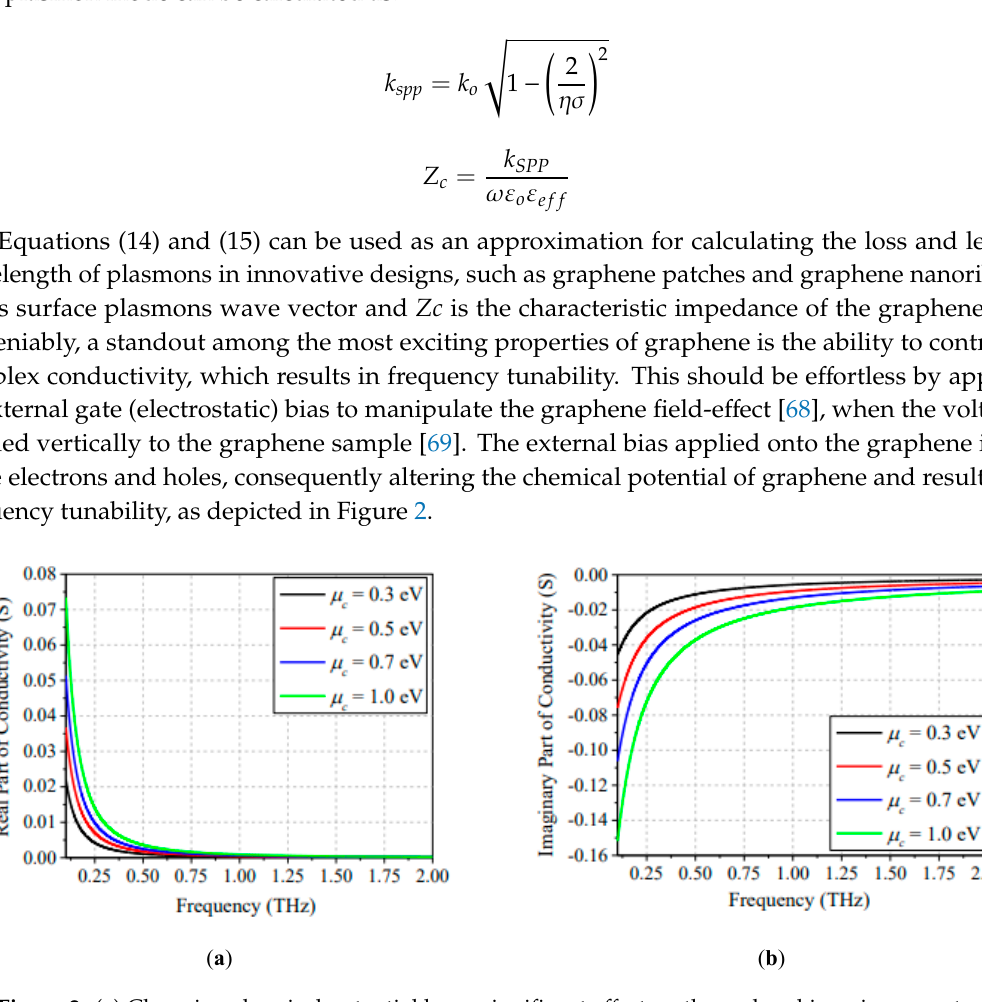
Figure 2. ( a ) Changing chemical potential has a significant effect on the real and imaginary parts of graphene conductivity at terahertz frequencies; and ( b ) conductivity behavior of graphene with respect to electrostatic biasing, i.e., changing chemical potential at higher frequencies. © 2019 APS. Reprinted with permission from [69].